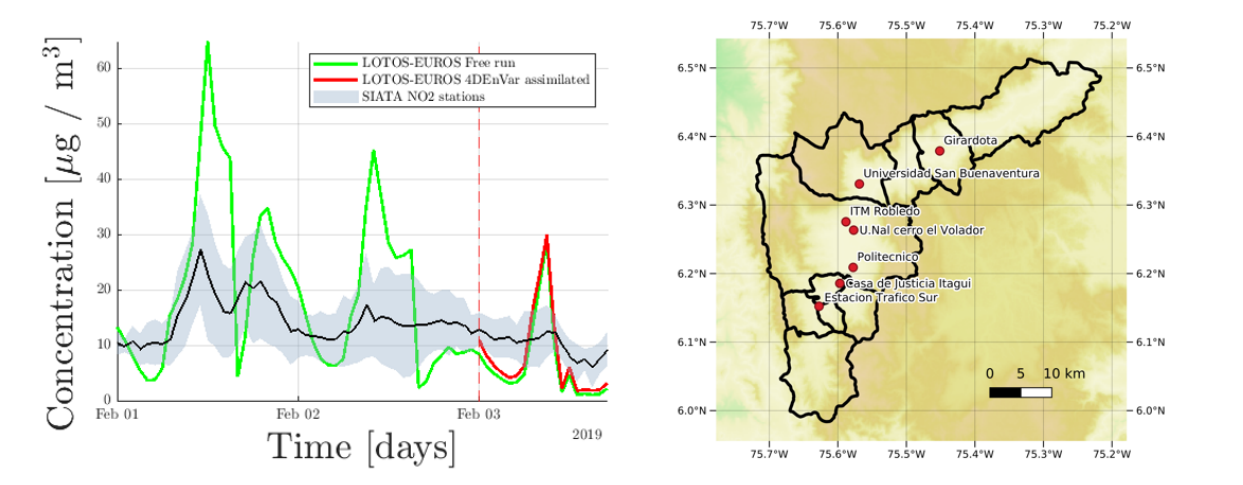
Figure 13. ( Left ) Time variation of hourly NO 2 data for Seven station from the SIATA network of NO 2 compared with the no assimilated (green line) and 4DEnVar assimilated (red line) model output. Grey shaded area denotes de deviation from the individual stations. Spatial distribution depicted with the red circles of the ( Right ) NO 2 stations over the Aburrá